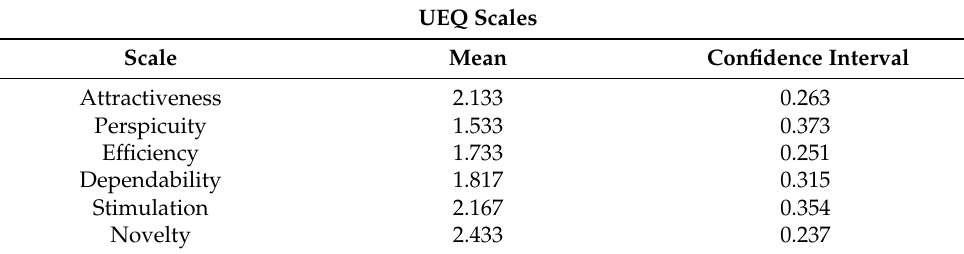
Table 1. Mean values and confidence interval for each scale (Attractiveness, Perspicuity, Efficiency, Dependability, Stimulation, and Novelty). UEQ Scales Scale Mean Confidence Interval Attractiveness